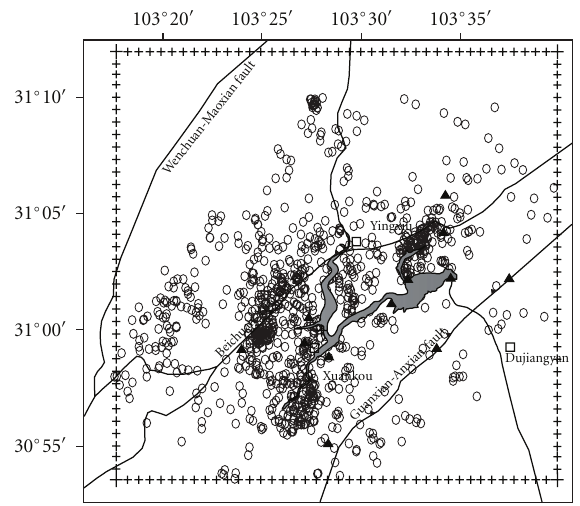
Figure 3: Distribution of the local earthquakes used in the present study. Ellipses denote earthquake epicenters given by the double- di ff erence relocation. Solid triangles are all stations (temporary + permanent) used in the relocation and tomography inversion. The plus symbols present the area of the tomography grids and that of velocity inversion as shown in Figure 5. The others are the same as in Figure